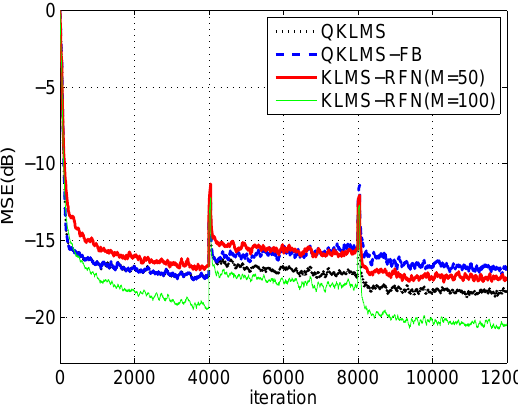
Figure 12. The learning curves of the QKLMS, QKLMS-FB, and KLMS-RFN algorithms in channel equalization with an abrupt change in condition.